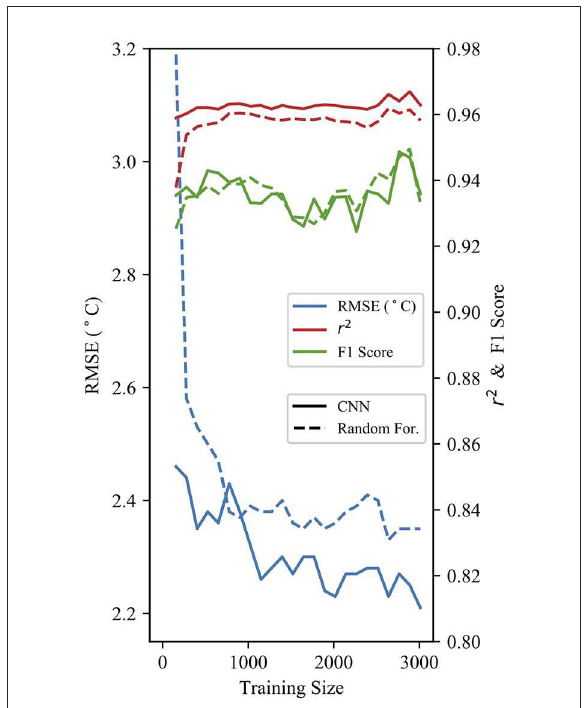
FIGURE7 Performance statistics for both RF and CNN models at various training dataset sizes for 24-h